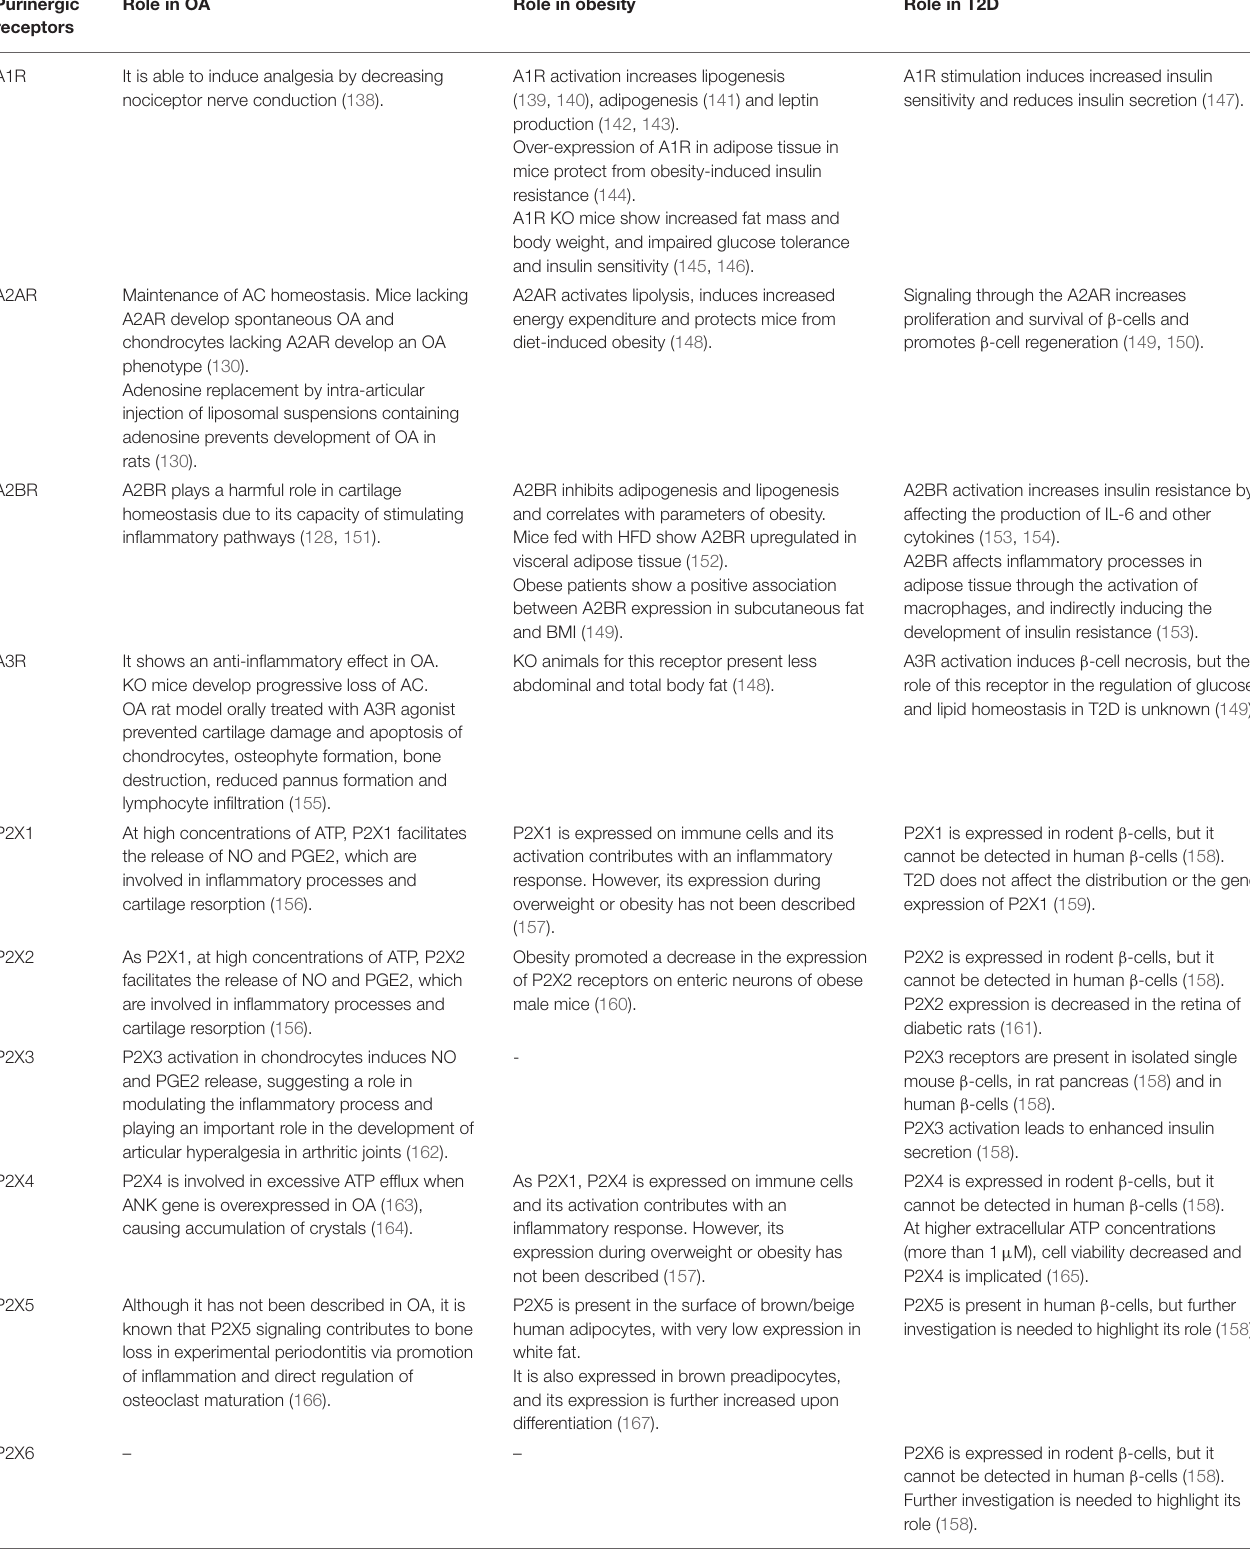
TABLE 2 | Description of purinergic receptor roles in osteoarthritis (OA), obesity and type 2 diabetes (T2D). Purinergic Role in OA Role in obesity Role in receptors